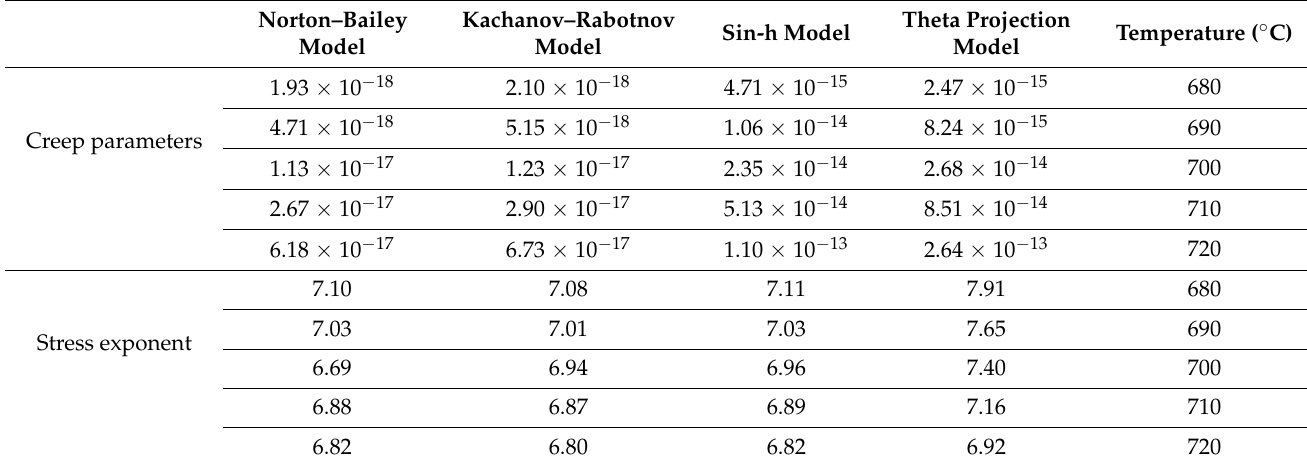
Table 3. Material constants for SS-304 for creep models at (680–720) ◦ C and (20–60) MPa.